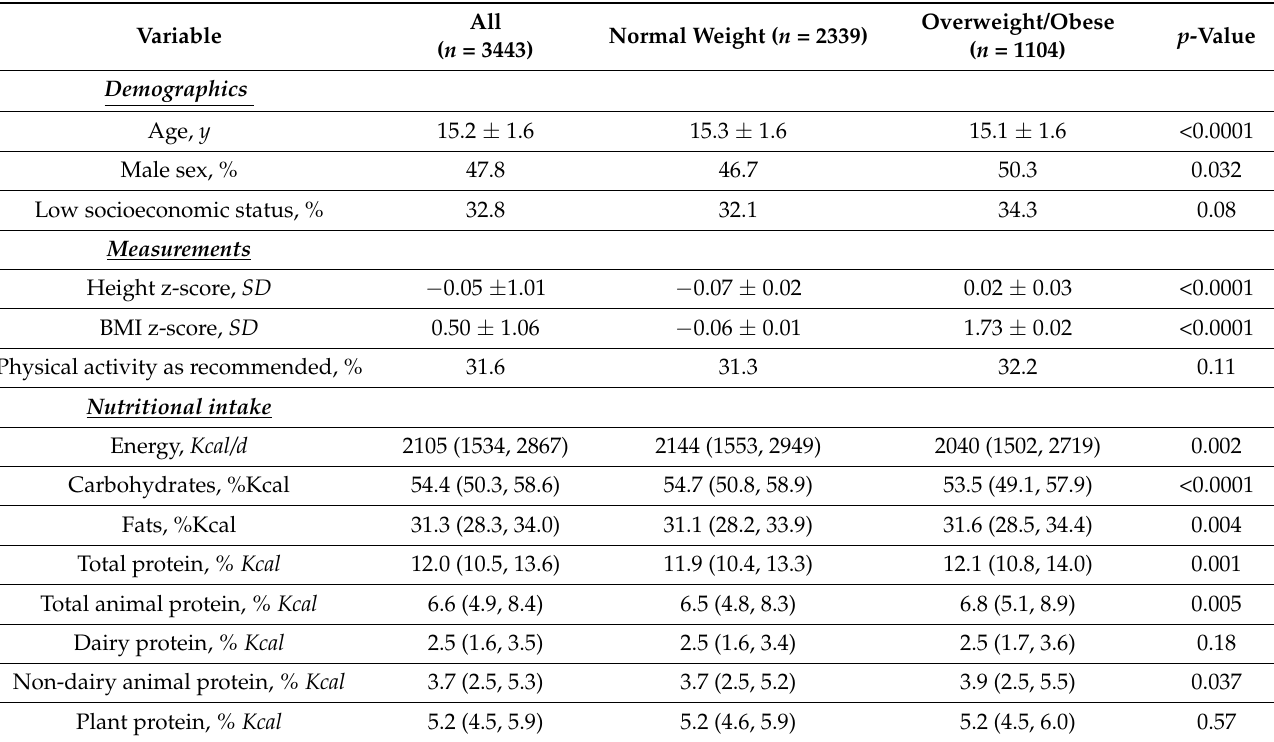
Table 1. Demographic, health, and nutritional characteristics of study participants according to weight status 1,2